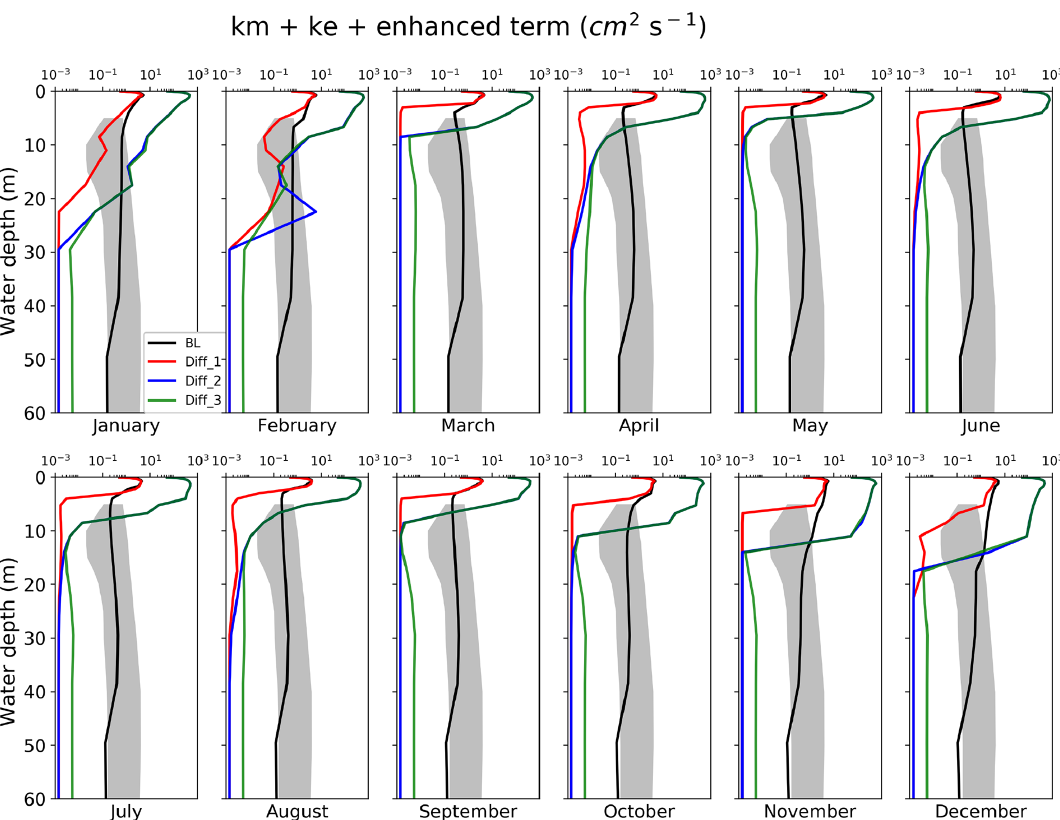
Figure 9. Monthly vertical diffusivity profile for the first 60m water by BL (black line), Diff_1 (red line), Diff_2 (blue line), and Diff_3 (green line) in the year 2015. The gray shading indicates the diffusivity range of Lake Zürich reported by Li (1973).